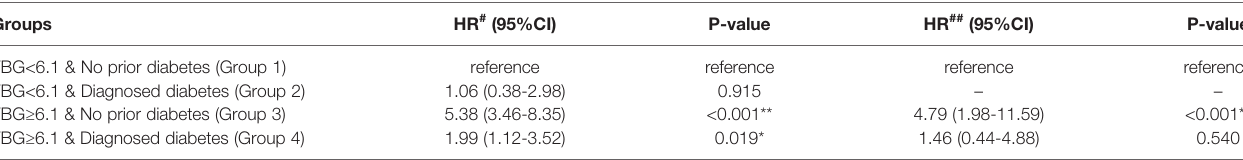
TABLE 2 | Adjust Hazard Ratio of FBG levels and diabetes to ICU admission in COVID-19 patients. (Unit of FBG is mmol/L). Groups